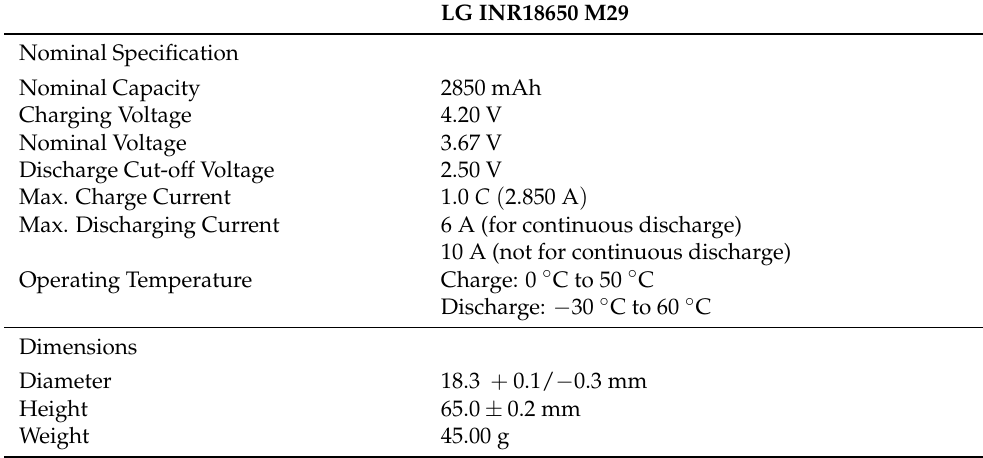
Table 1. Product specification of the cylindrical Li-ion battery cell applied [17].